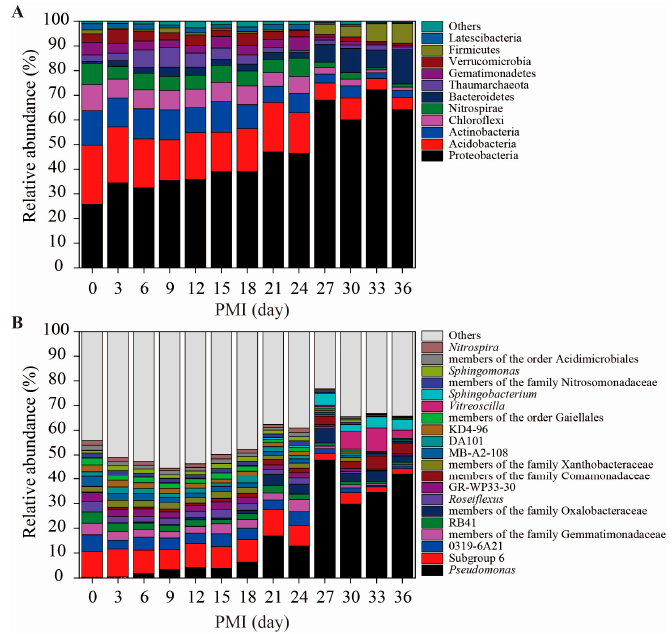
Figure 1. The relative abundances of the main bacterial members for different gravesoils. The stacked bar graph represents the relative abundances (%) of the major bacterial community, and only the average relative abundance > 1% for phylum ( A ) and the top genera ( B ) for genus across all the samples are shown. The relative abundance of each taxon is the average value of five replications (four replications for days 3, 27 and 30).